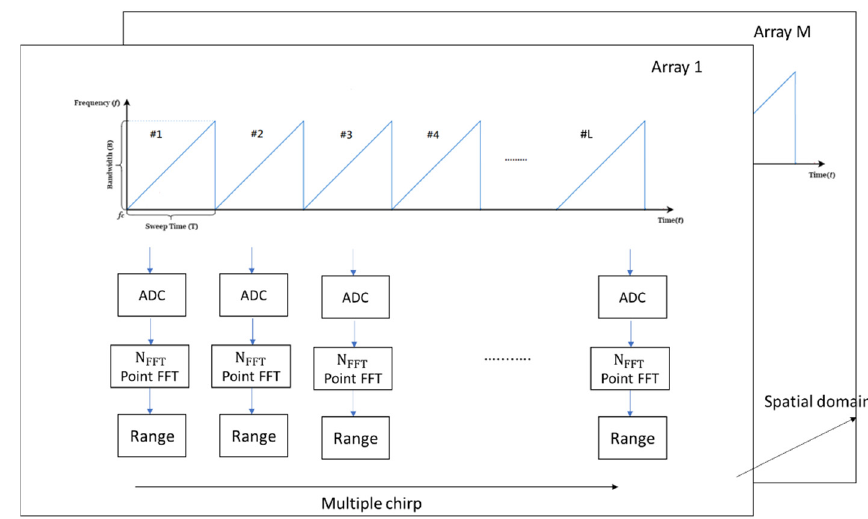
Figure 1. Generation of a data cube.